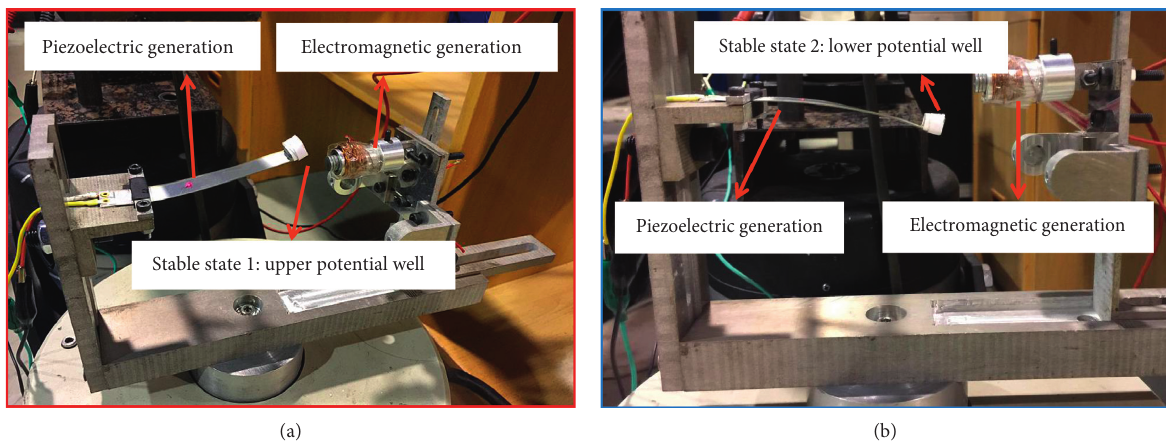
Figure 6: Diagrams of experimental setups: (a) structure is placed in the upper potential well; (b) structure is placed in the lower potential well.